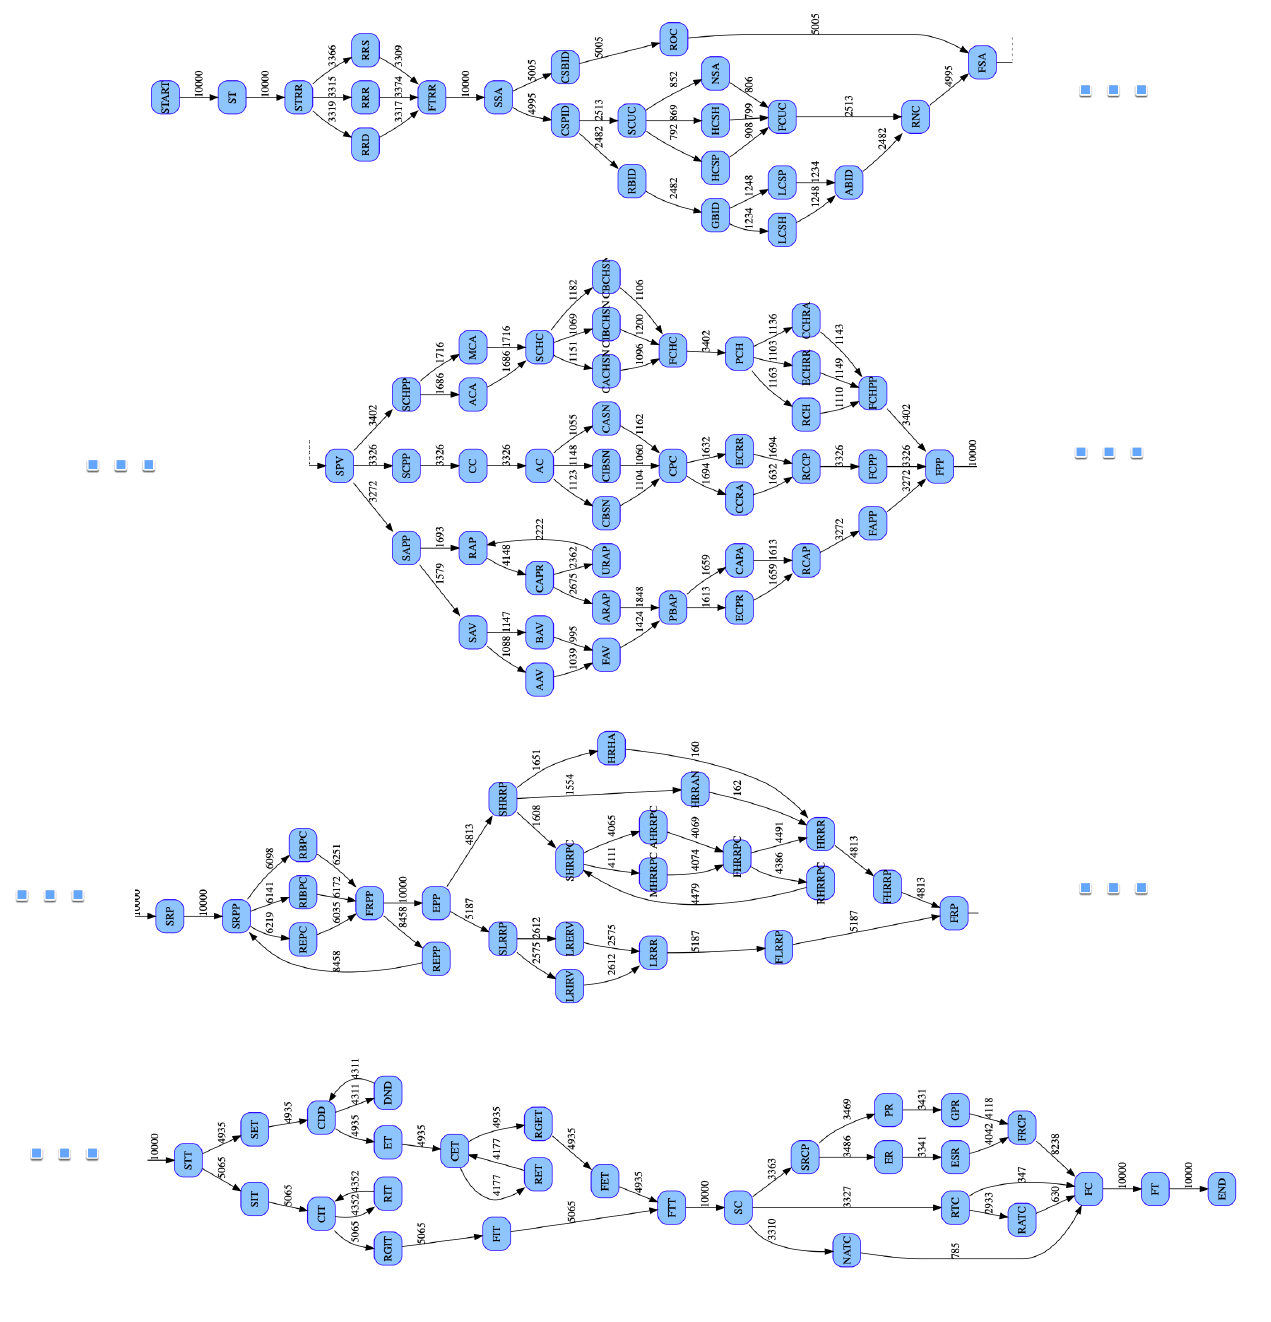
Figure 6. A group of process pattern graph models after removing the noises, each of which is corresponding to each subprocess in the Large Bank Transaction Process